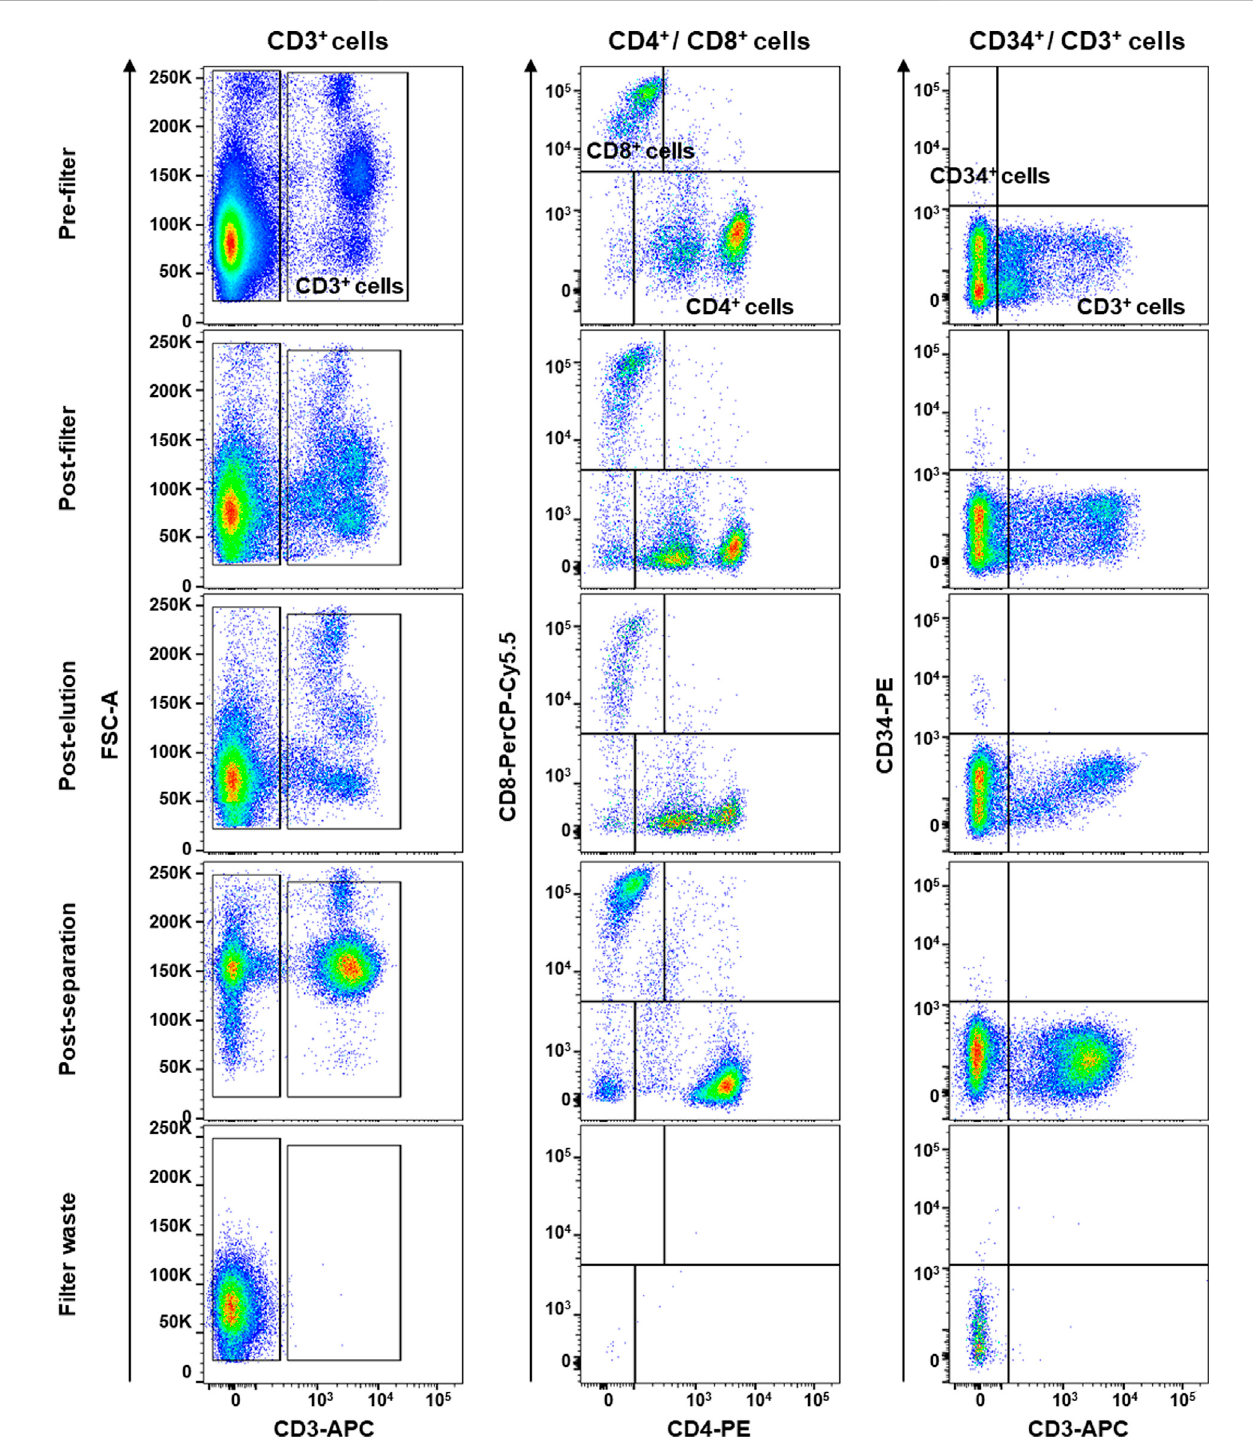
FIGURE 4 Flow cytometry immunophenotyping of peripheral blood mononuclear cells (PBMCs) obtained by whole blood was collected and fi ltered by a HemaTrate ® Blood Filtration system. PBMC different population fraction was subsequently separated by Ficoll-Paque density gradient separation to perform fl ow cytometry immunophenotyping on pre- and post- fi ltration, post-elution, post-separation, and on the fi lter bag waste, as negative control. Frequencies of CD3 + T lymphocytes and CD8 + and CD4 + subsets and circulating CD34 + hematopoietic stem cells were